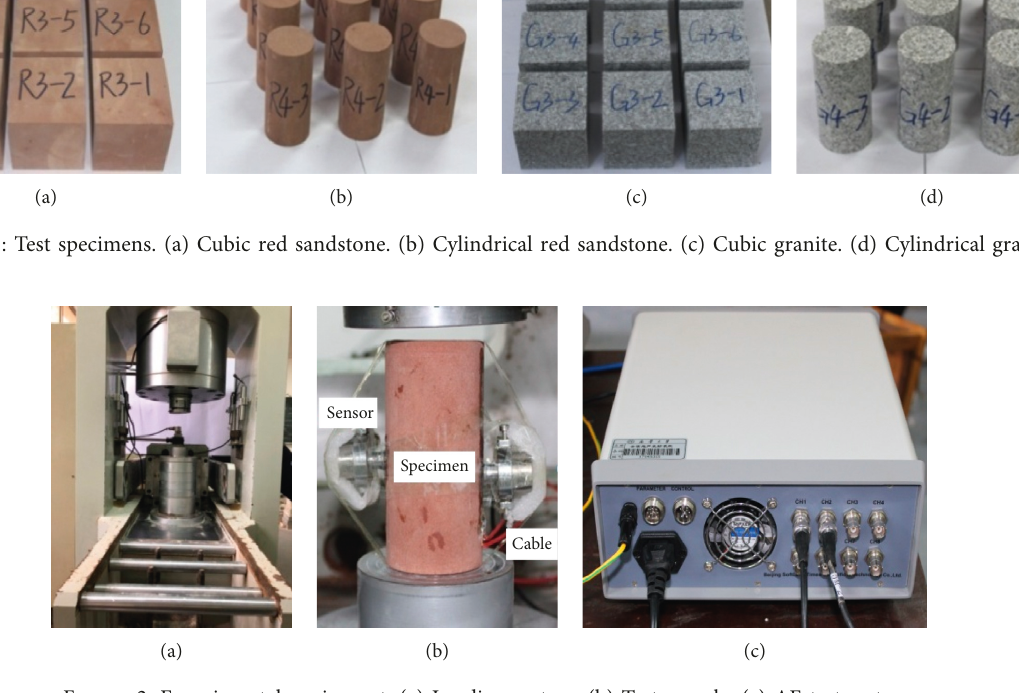
Figure 2: Experimental equipment. (a) Loading system. (b) Test sample. (c) AE test system.